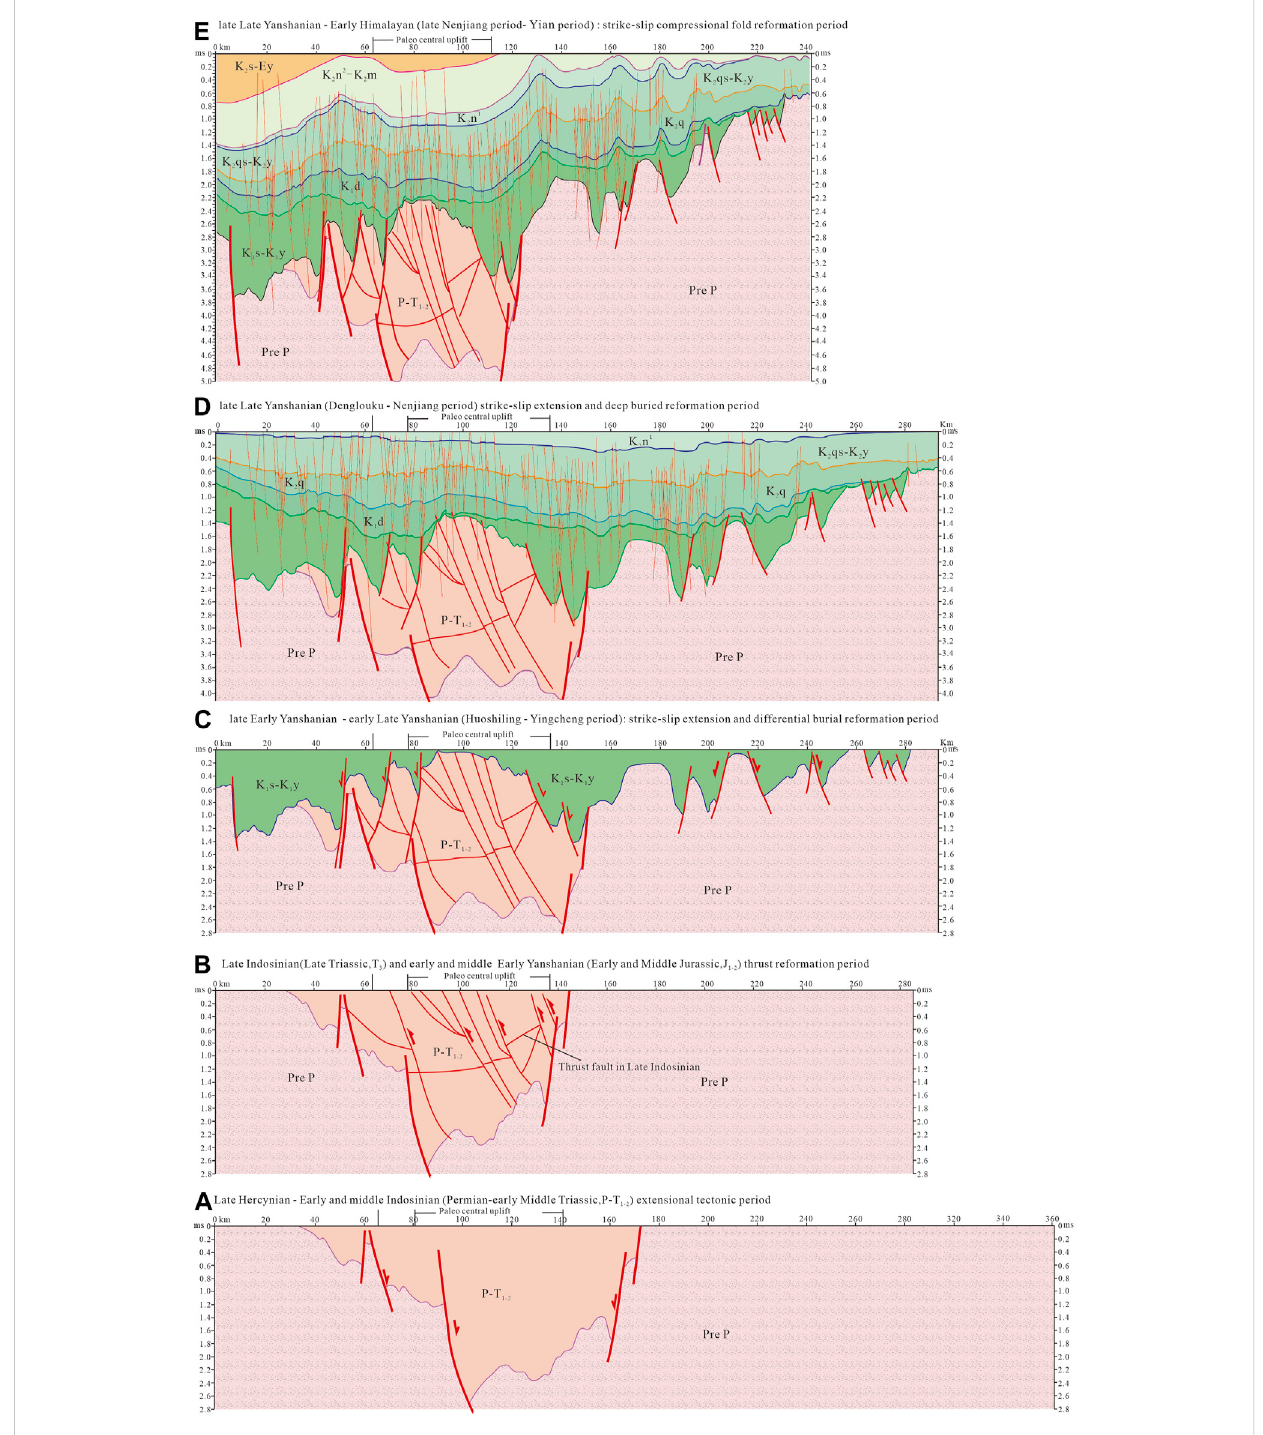
FIGURE 5 Structural evolution of east – west section of SL2 in Songliao Basin (location of the section is shown in Figure 1).